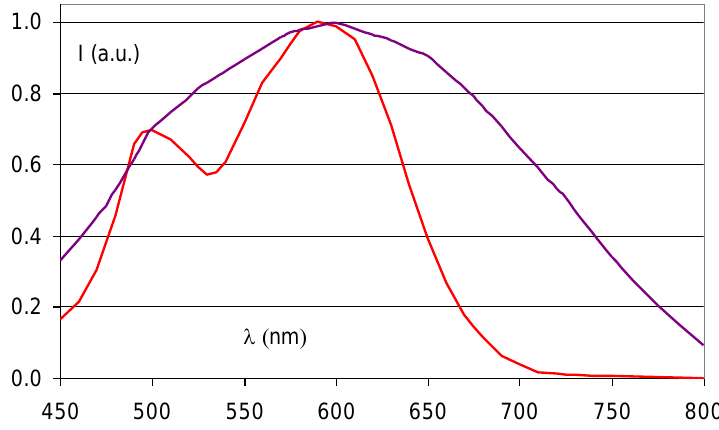
Figure 16. Stimulation spectra of Ba BaFBr:Eu 2+ (red).